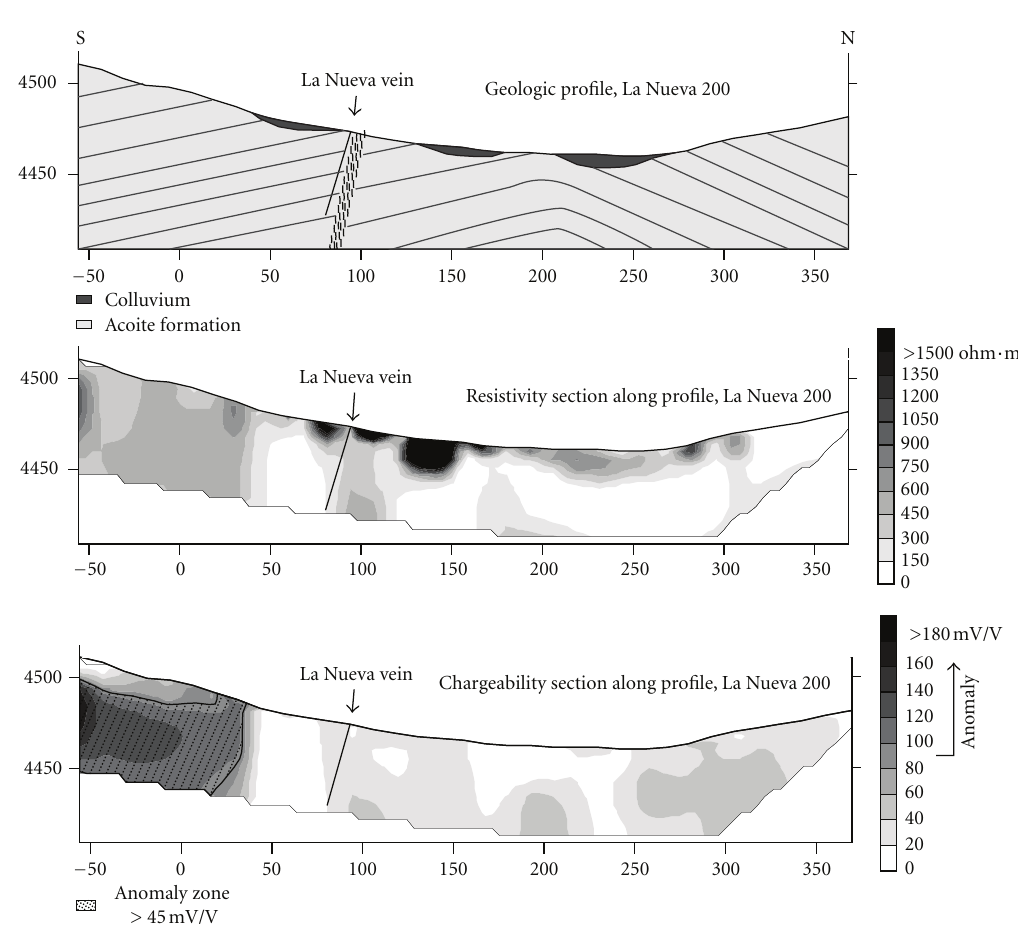
Figure 6: Geological, resistivity, and chargeability profile no. 200 for La Nueva section. The vein studied is spatially associated with low- resistivity and -chargeability areas. A large area presenting anomalous chargeability is located southward of the